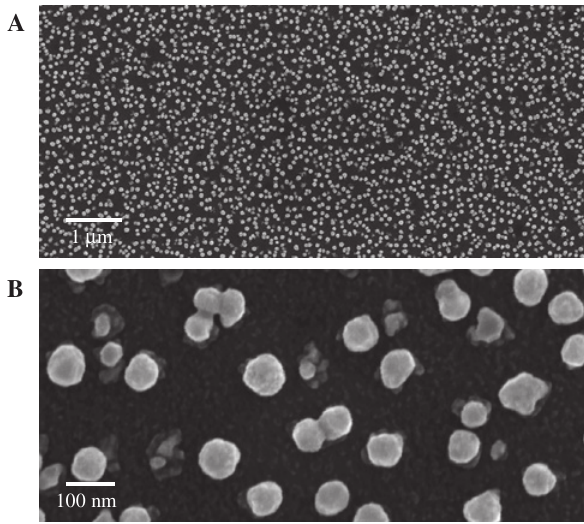
Figure 2: SEM images of silver NPs deposited by electroless plating on GaAs substrate. (A) Overview and (B) zoom-in images. Top view of typical NP shapes such as circular, elliptical, and over- lapping dimers.